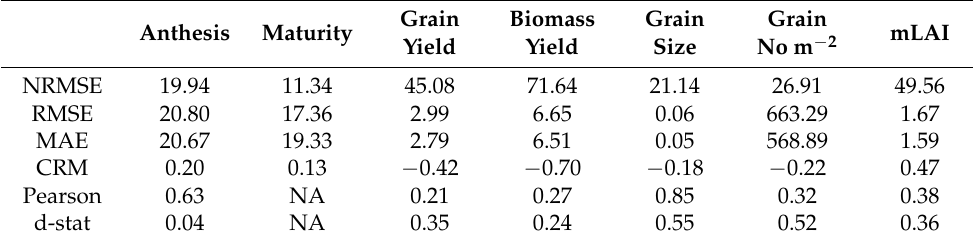
Table 15. Results of the validation statistics for the CERES-Maize model under irrigated